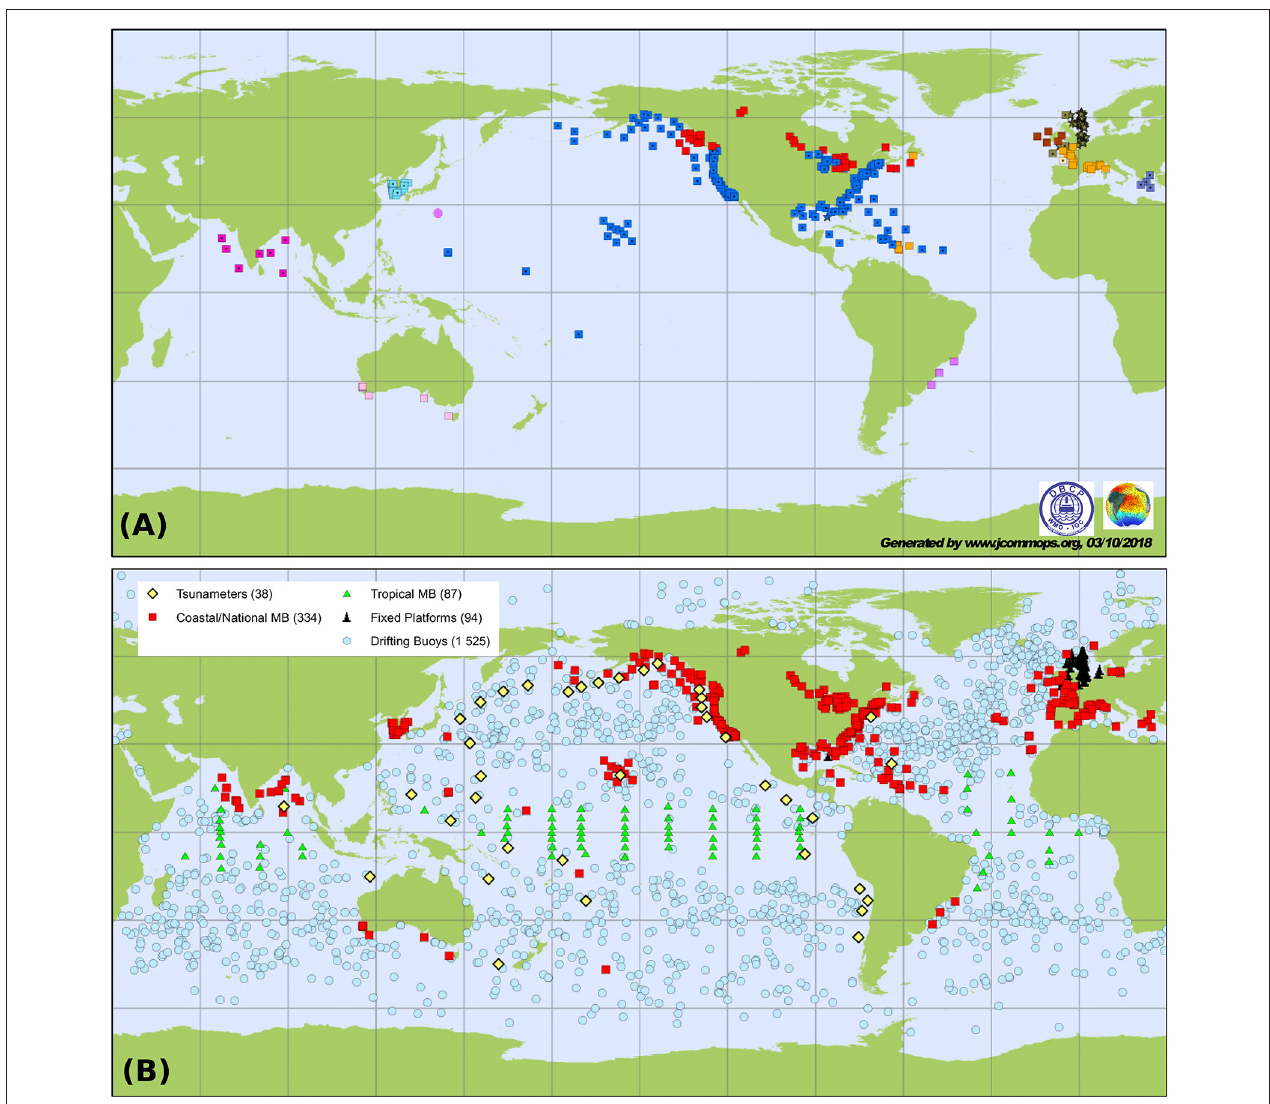
FIGURE 13 | (A) Fixed locations for wave data transmitted via JCOMM, with different colors for different countries, and (B) location of surface instruments transmitting data through the GTS as part of the Data Buoy Cooperation Panel (DBCP) which could all be equipped with cheap wave sensors, source http://www.jcommops.org/